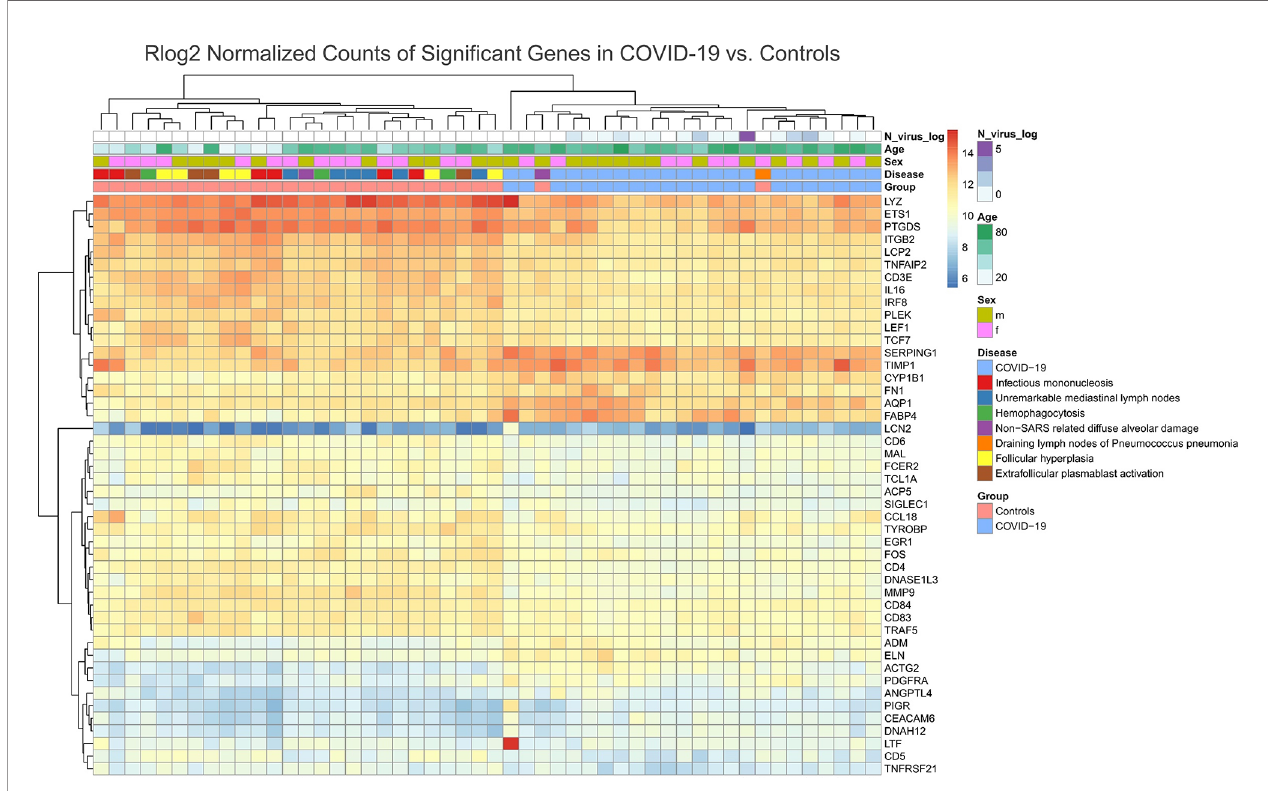
FIGURE 7 | Unsupervised Cluster Analysis of Differentially Expressed Genes in the Draining Lymph Nodes of COVID-19 Compared to Control Cases. A downregulation of genes related to T-cell function and differentiation (LCP2, CD3E, LEF1, CD6, MAL, TCL1A, TYROBP, CD84, CD5), in particular CD4 associated (IL16, CD4) and genes encoding for immunoglobulin receptors (FCER2, PIGR) and transcription factors (ETS1, EGR1, FOS) was observed in COVID-19 patients versus controls. A downregulation of LYZ and SIGLEC1 indicates an altered macrophage phenotype (less prevalent M1 polarization). Genes related to complement and fl uid homeostasis and vascular functions (SERPING1, AQP1, ADM, ANGPTL4) are upregulated. A dysregulation in expression amongst genes encoding for leukocyte adhesion and motility was observed (downregulation of IRGB2, upregulation of ACTG2 and DNASH12). MMP9 is downregulated while its inhibitor TIMP1 is upregulated. Other genes involved in remodeling (ELN, PDGFRA and FN1) are upregulated. A downregulation of PTGDS and upregulation of CYP1B1 indicates an altered arachidonic acid